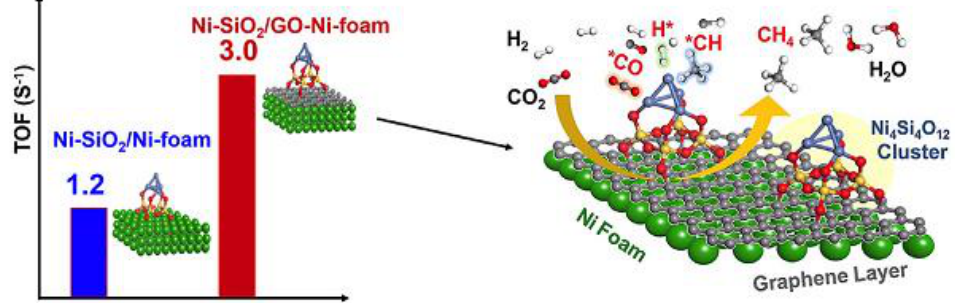
Figure 7. TOF of Ni-SiO 2 /Ni-foam and Ni-SiO 2 /GO-Ni-foam catalysts for CO 2 methanation, reprinted with permission from [35]. Copyright Elsevier, 2019.